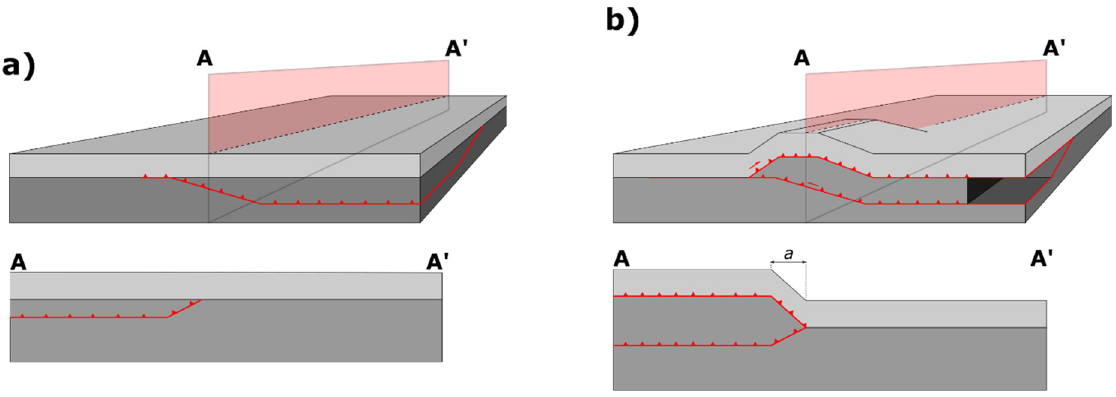
Figure 15. Schematic cartoon (not to scale) showing the mechanism responsible for extension in the hanging-wall lateral culmination wall. ( a ) A simple two-layer model with a future thrust marked by the red line, ( b ) Duplex formation causing doming of the upper lay, based on [100,101].